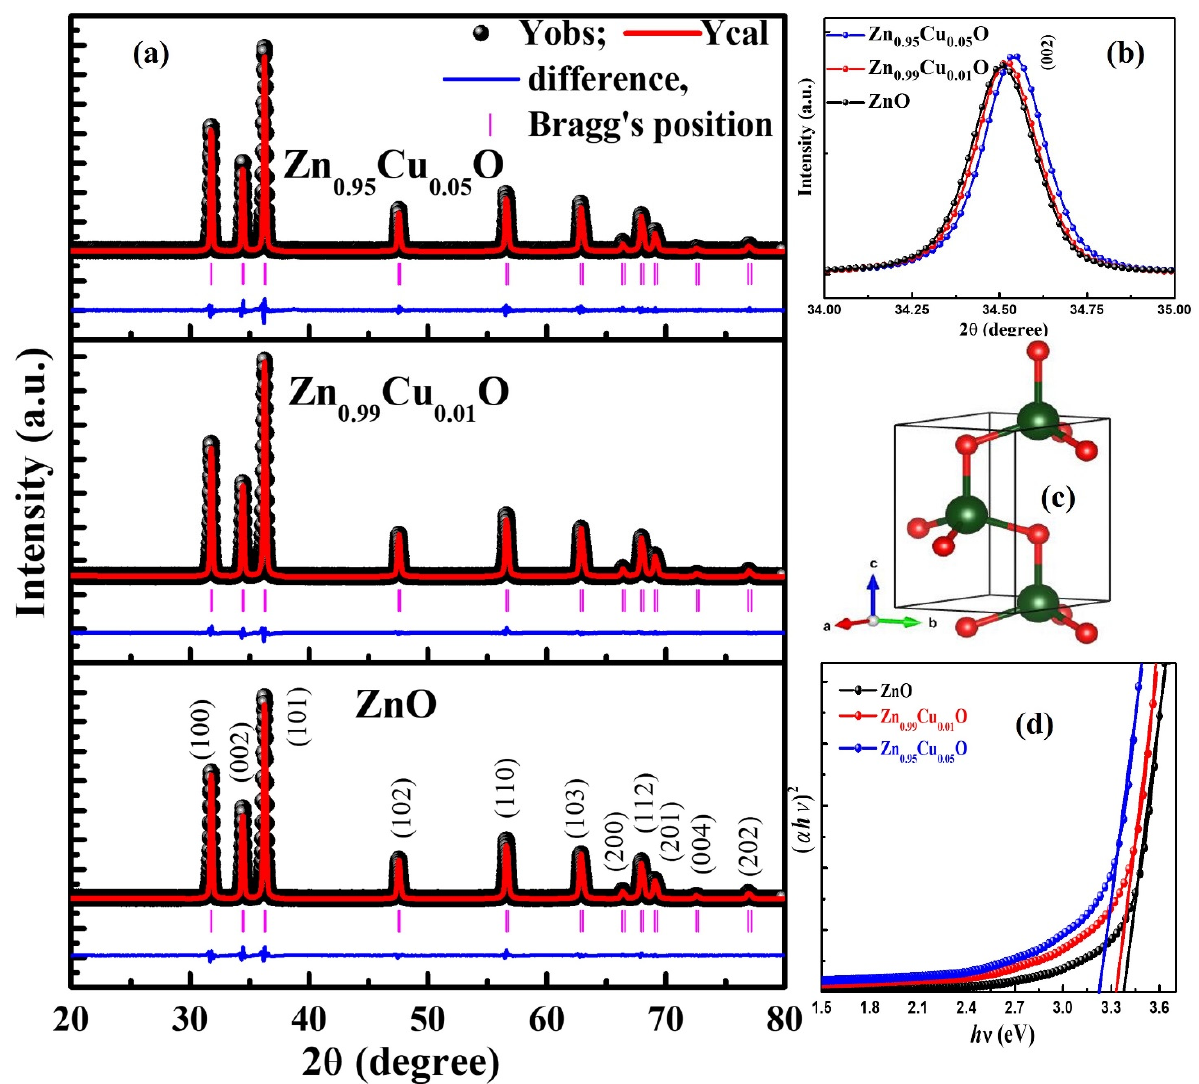
Figure 2. ( a ) Rietveld profiles of XRD patterns of Cu-doped ZnO nanostructures. Observed profiles are shown by the black spheres and calculated profiles are shown by red lines. The pink color vertical sign denotes the Bragg reflections and difference plot is shown blue line. ( b ) Peak shifting (002) plane of Cu-doped ZnO nanostructures. ( c ) Representation of unit cell structure of ZnO nanostructures; green (bigger spheres represent the host atom ‘Zn’, while the small spheres in red color denote the O atoms). ( d ) PL spectra Cu-doped ZnO nanostructures ( λ exc = 325 nm).